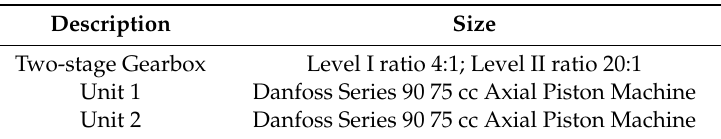
Table 4. Major components of wheel loader HST.